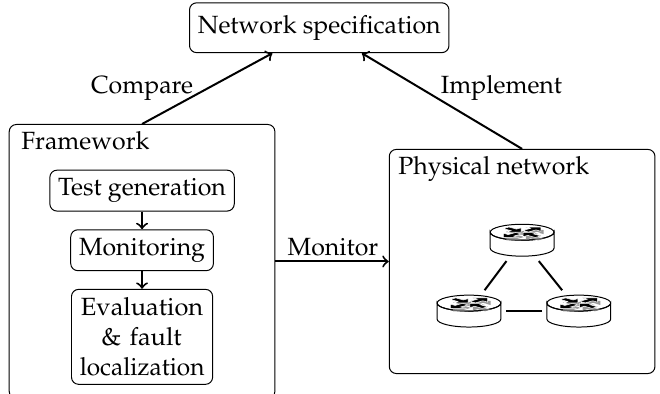
Our framework’s relationship with the outside world: Network specification and physical